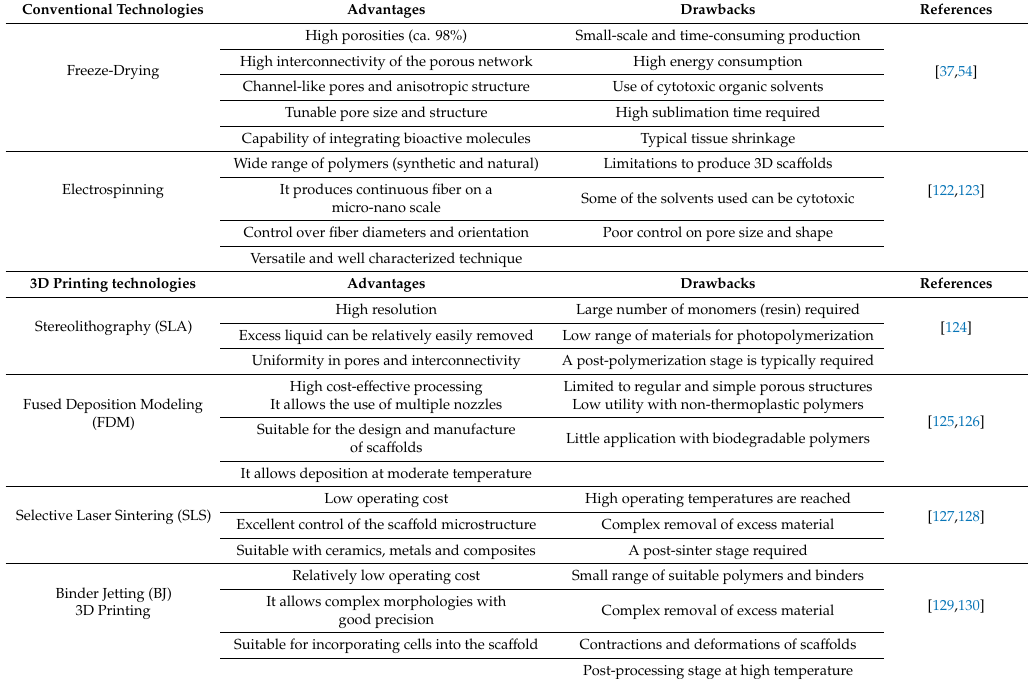
Table 2. Advantages and drawbacks of the di ff erent processing techniques to produce sca ff olds.